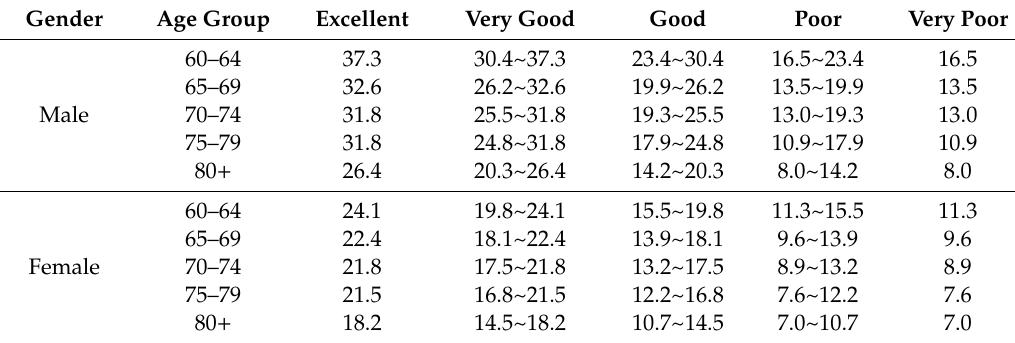
Table 15. Grip strength 5-grade relative evaluation norms, Unit: kg.